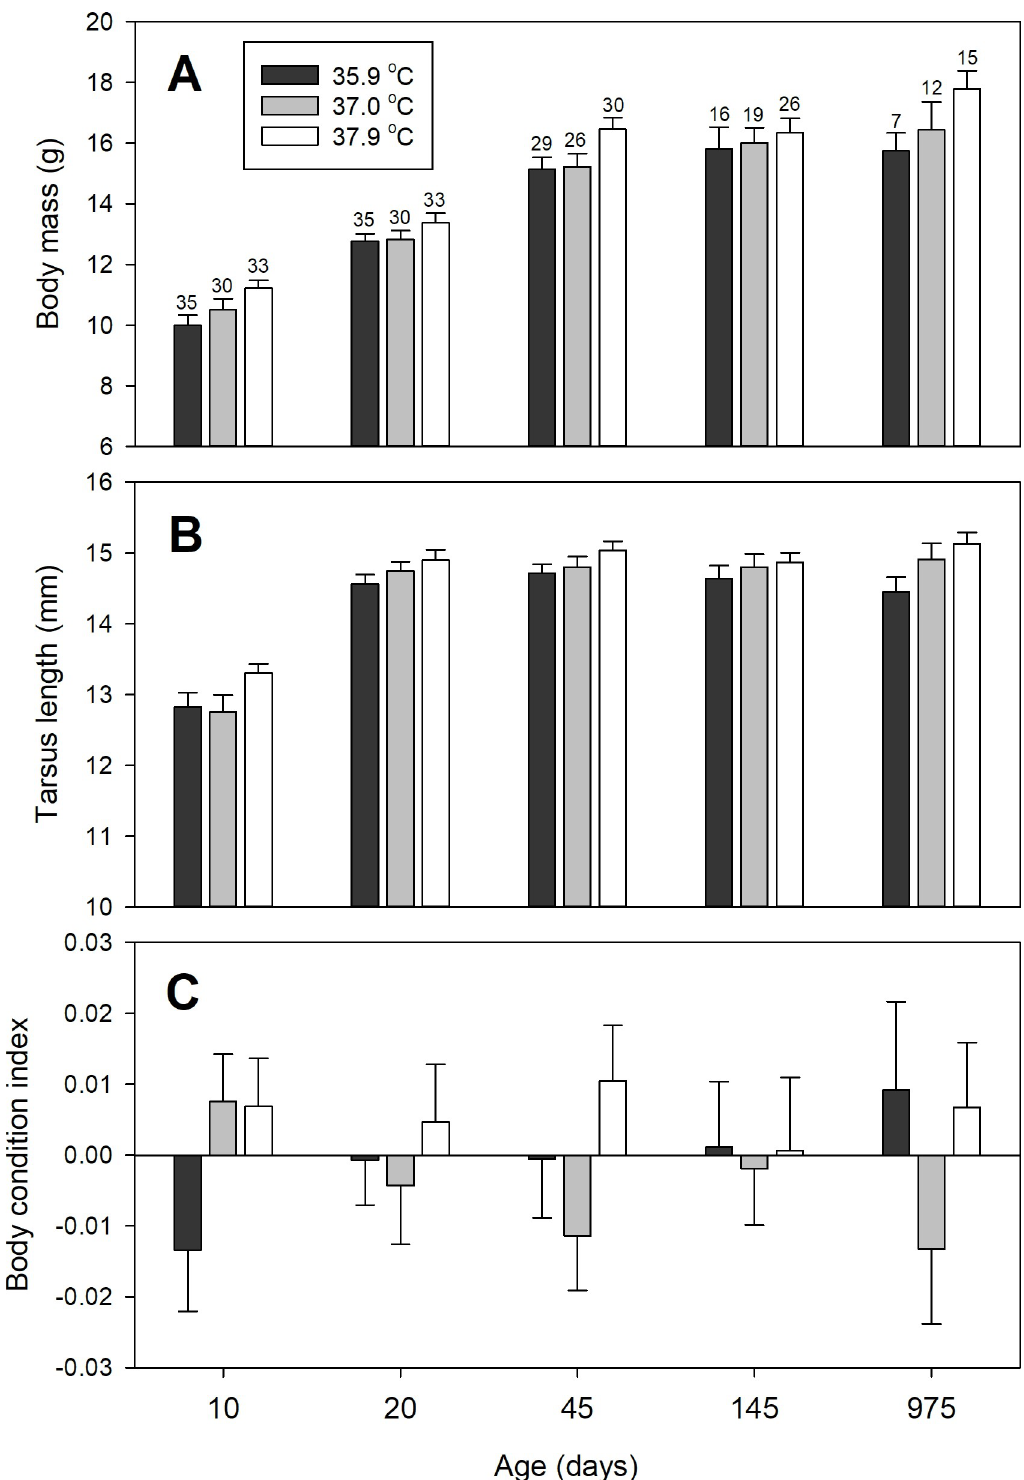
Fig 1. Body mass and biometry changes with age. Body mass (A), tarsus length (B) and body condition index (BCI; C) at different ages for birds incubated at 35.9˚C (black), 37.0˚C (grey) and 37.9˚C (white). Shown are means ± SE. Sample sizes are given above the error